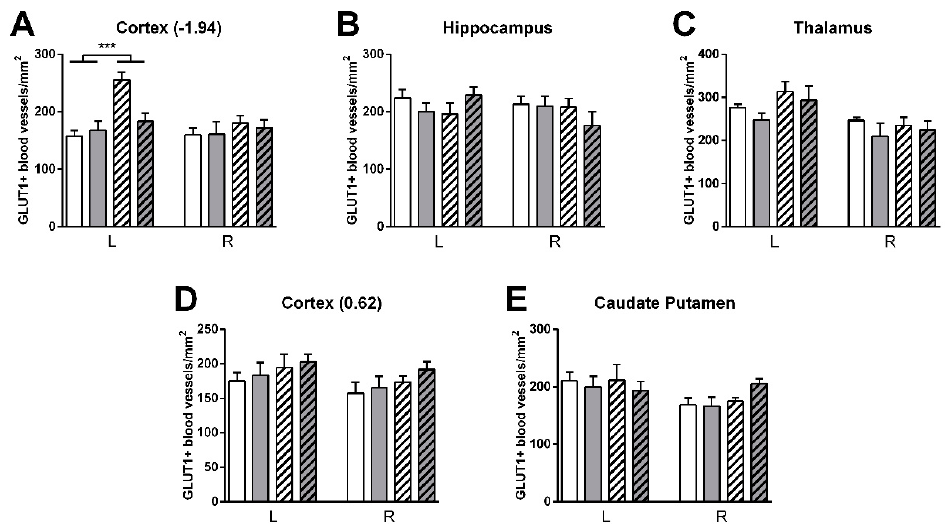
Figure 15. Immunohistochemical stainings for GLUT-1 in brains of HT and control fed mice 35 days after surgery. ( A – E ) Vascular density was increased in control stroke compared to control shams in the left cortex (bregma − 1.94) ( p < 0.001). HT stroke mice had a lower vascular density in the left cortex (bregma 0.62) than control stroke mice ( p < 0.040 , data not shown). Values represent mean ± SEM. *** p < 0.001.